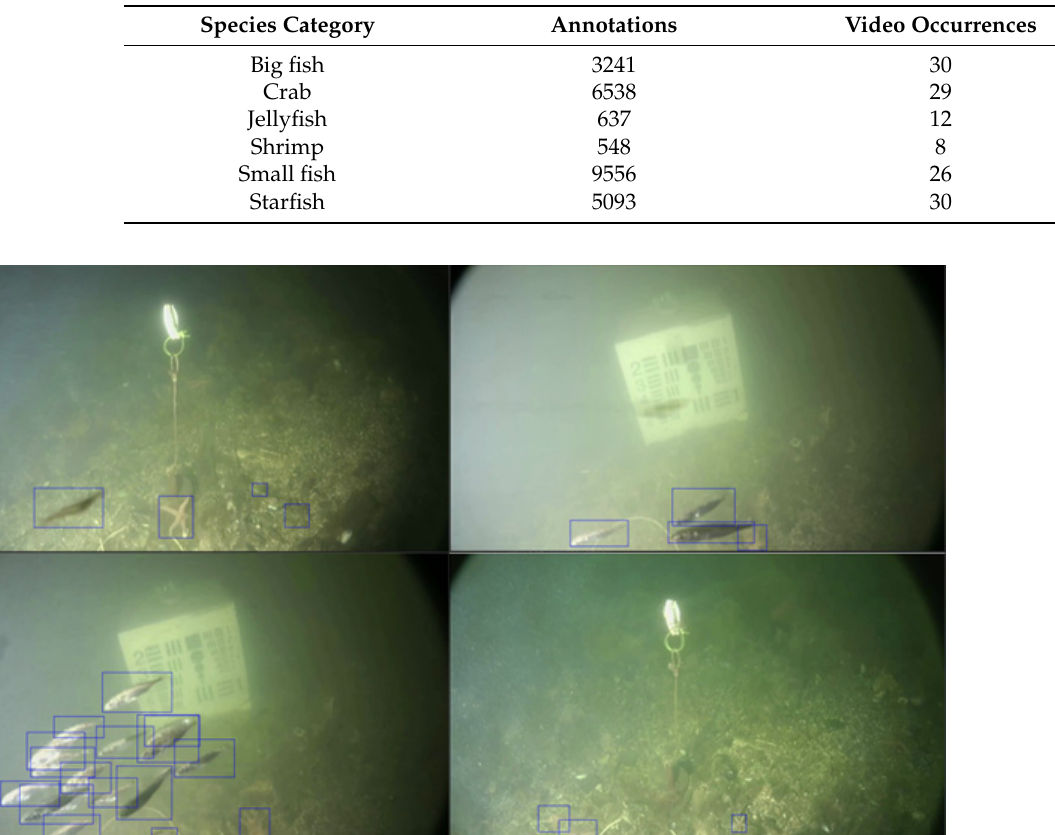
Figure 9. Training images from the URPC 2020. 4.2. Experimental Setup 4.2.1. Experimental Environment The experimental environment is shown in Table 3. The hardware used for this ex- periment was an Intel(R) Xeon(R) Gold 6130 CPU, 2.10GHz; NVIDIA RTX 2080ti graphics card, single GPU, 11G memory; Ubuntu 16.04 operating system; CUDA version 10.2; PyTorch version 1.2.0. The compiled virtual environment of Python was v3.6. Table 3. The environment for the experiments. Environment